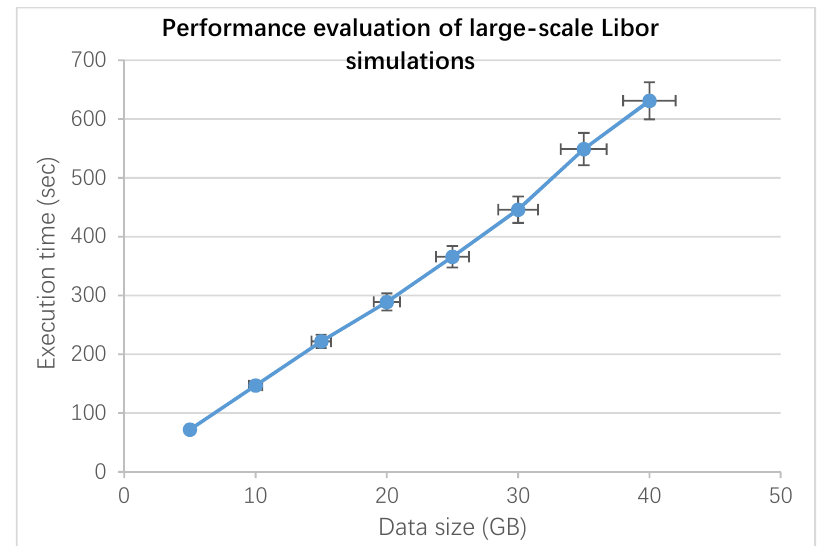
Figure 7. Performance evaluation of large-scale by LIBOR simulations.